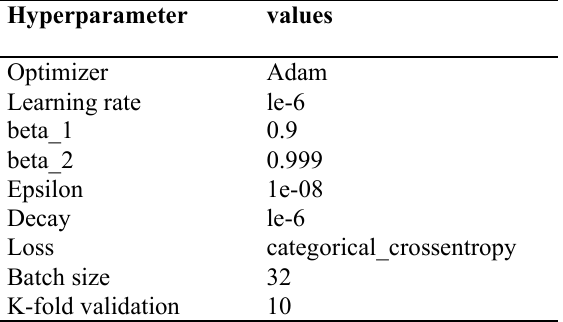
Table 4. Values of various